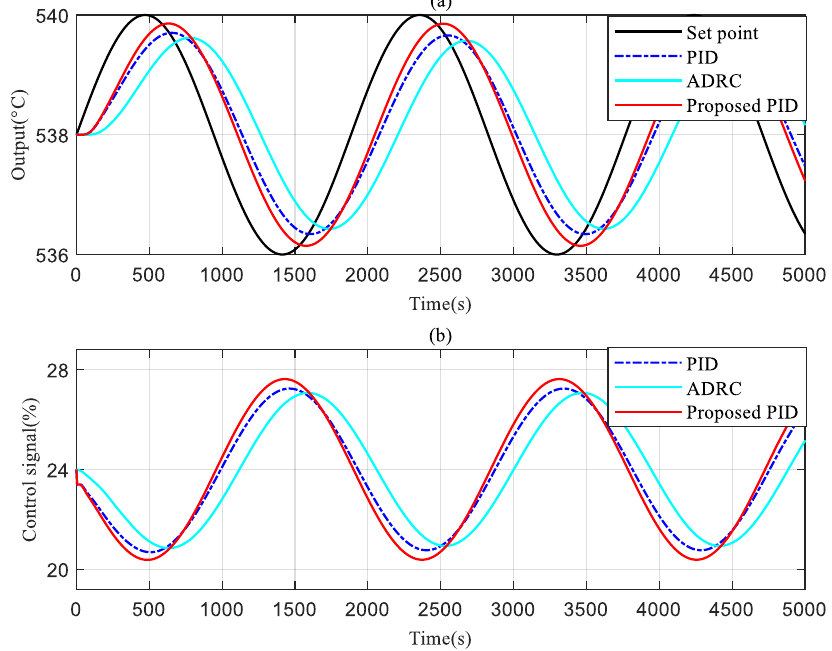
Figure 8. Set-point sinusoidal tracking performance under an operating condition of 100% load ( a ): outputs, ( b ): control signals.